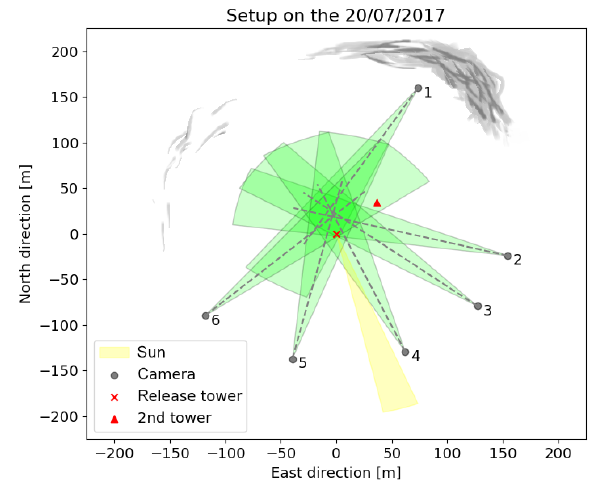
Figure 2. Map of the experimental setup. The cameras’ FOVs are indicated in green. The sun position (yellow) and the cloud cover (gray) as observed at 10:30UTC are sketched on the map. Coordi- nates are given relative to the release